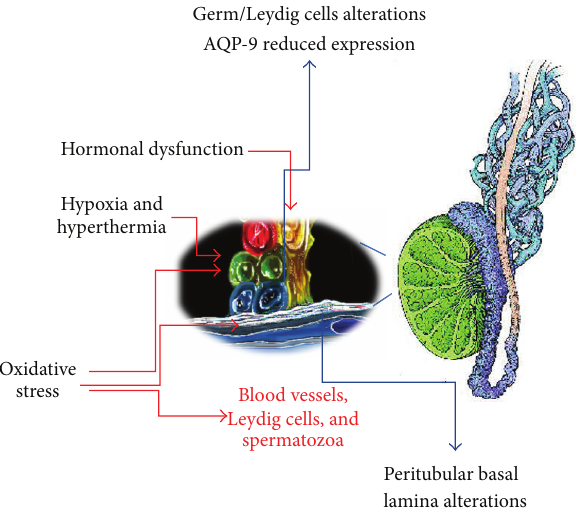
Figure 2: Different pathogenetic mechanisms of testis damage (red arrows) and different morphological alterations (blue arrows) observed in adolescent patients with varicocele. These mechanisms have been demonstrated in the adolescent age and could threaten testis throughout the